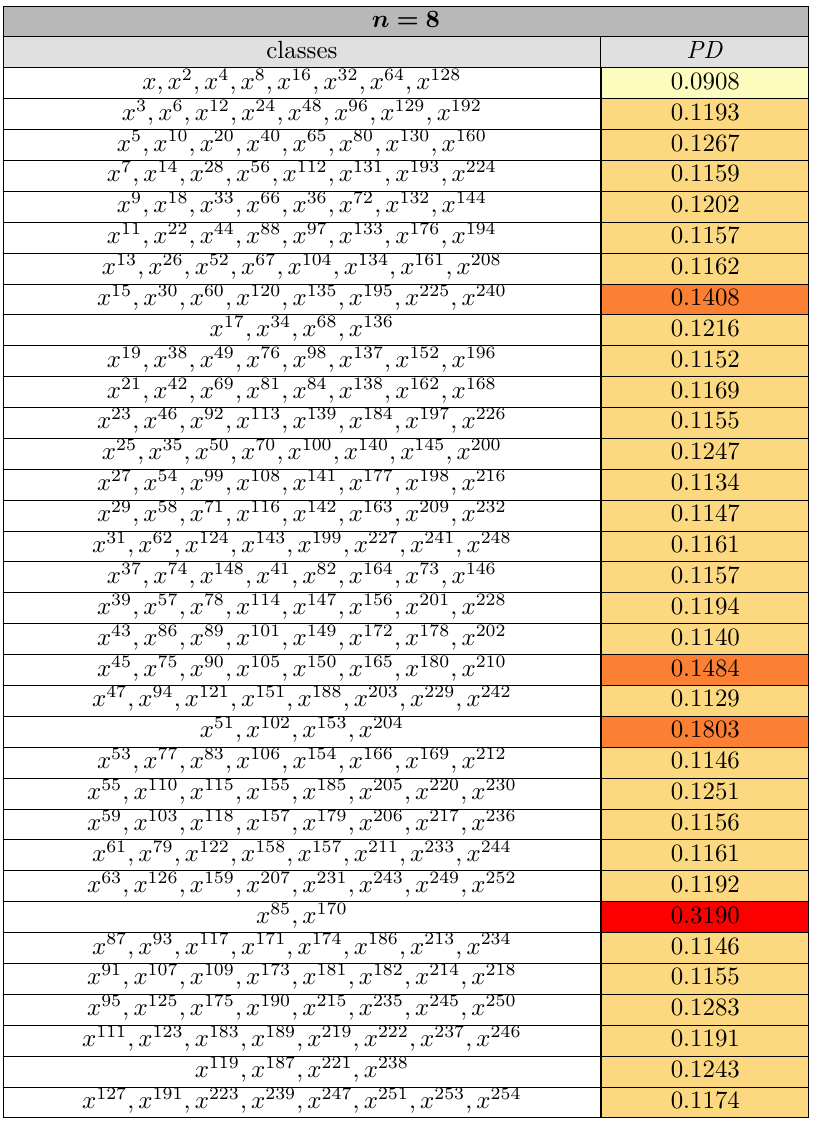
Table 4: The PD values of different classes for n = 8 based on x 8 + x 4 + x 3 + x +